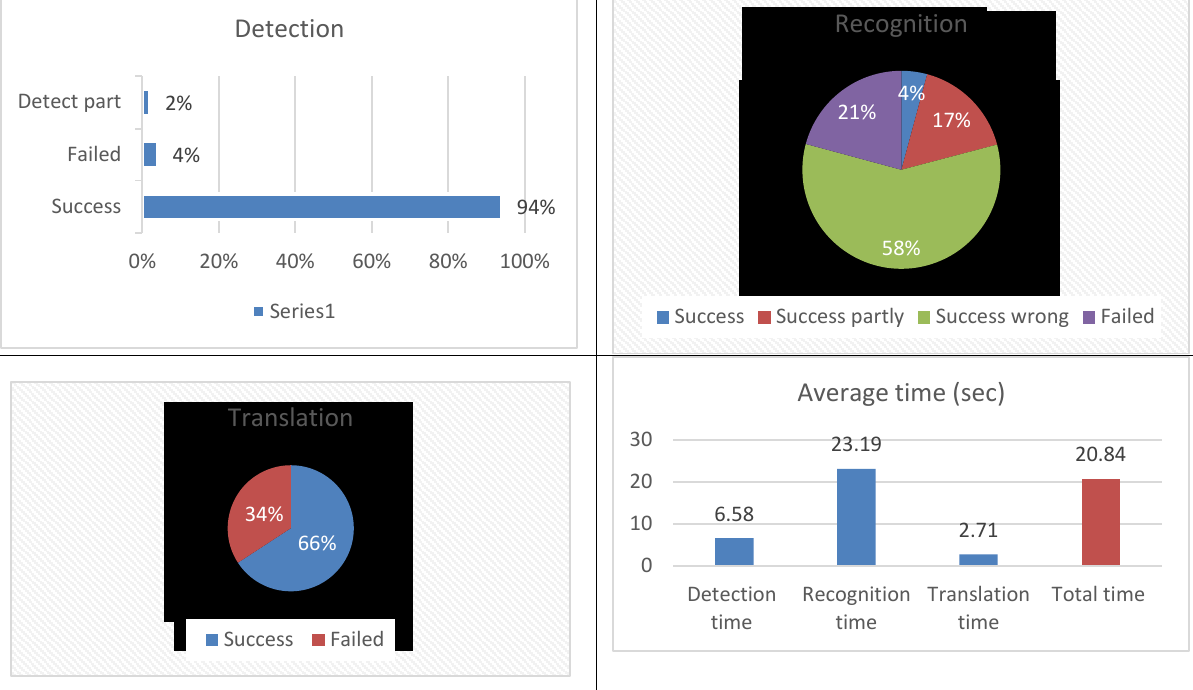
Fig. 9. Real-world dataset testing